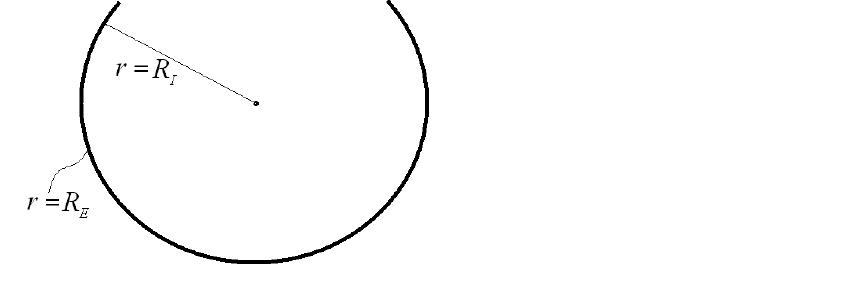
Figure 2. The studied problem. Spherical shell with internal radius R I and external radius R E .